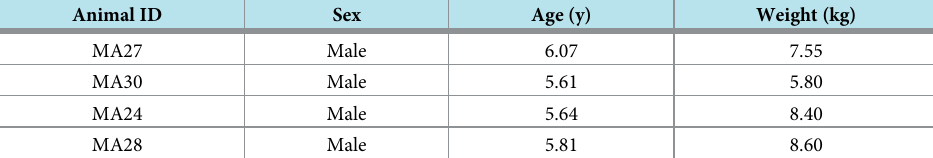
Table 1. PTM cohort used in this study, including sex and age and weight at the time of SARS-CoV-2 inoculation. Animal